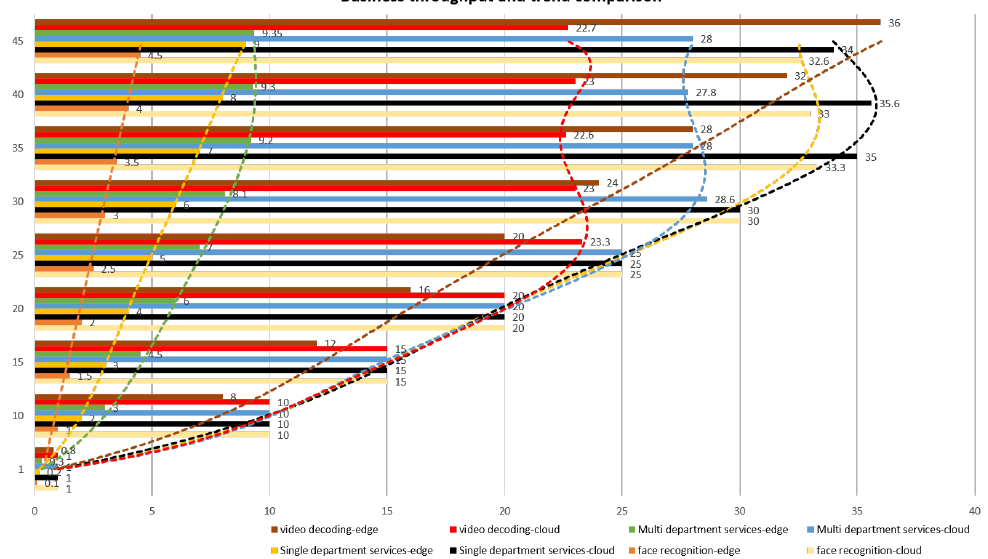
Figure 6. The business throughput and trend